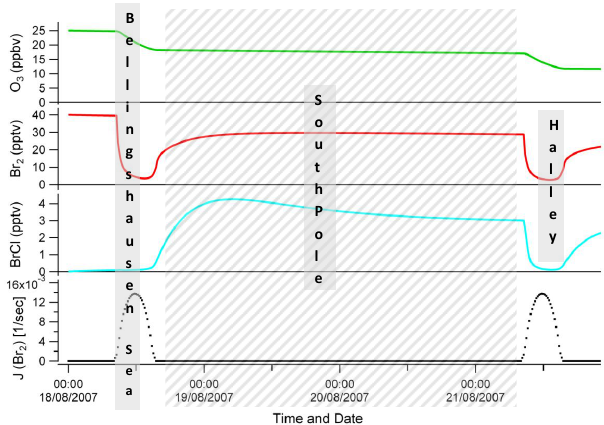
Fig. 12. MISTRA 0-D run 4 days in length showing [Br 2 ], [BrCl], [O 3 ] and J (Br 2 ) model output. Only the first and last of those days under the influence of sunlight (darkness is highlighted with the hashed grey box). Mixing ratio on the left axis, and time in hours since the start of the run along the bottom. The location of the air mass is highlighted at key stages of its transcontinental